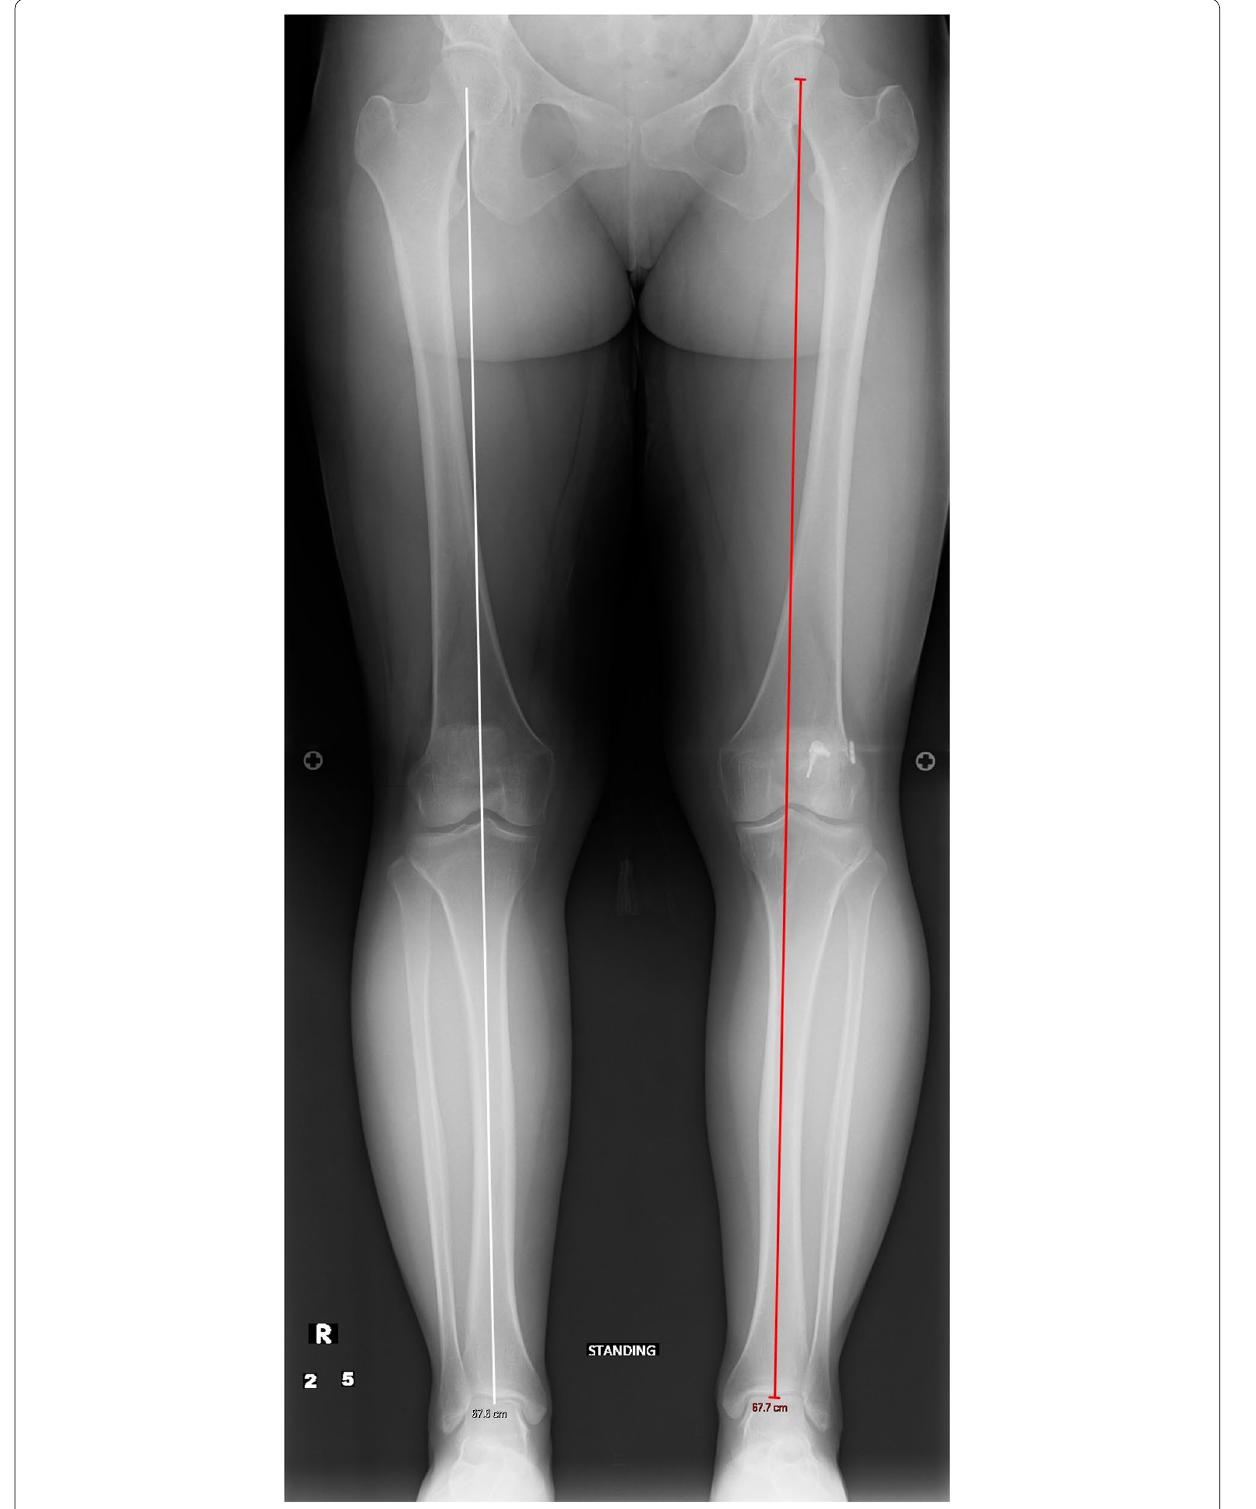
Fig. 3 A pre-operative standing mechanical axis radiograph demonstrating physiologic